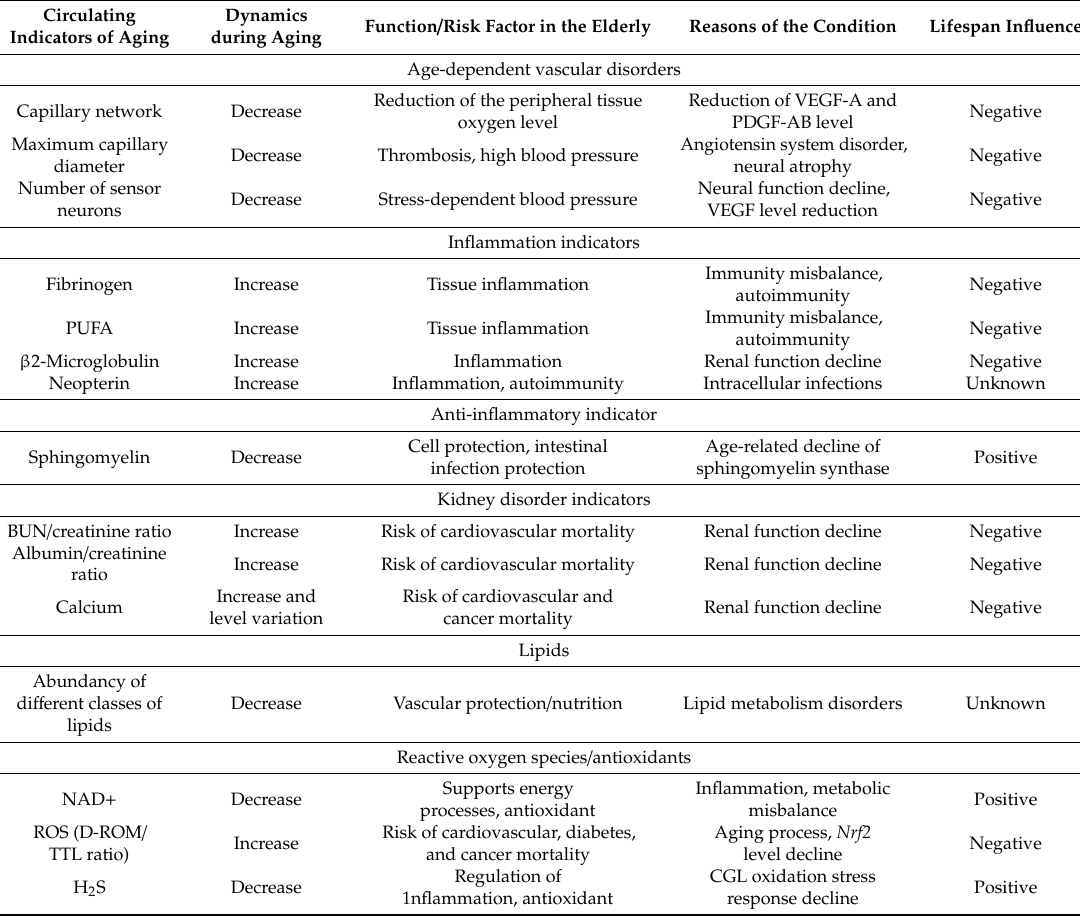
Table 1. Vascular conditions, metabolites, lipids, and redox agents as risk factors of age-related disorders and their influence on